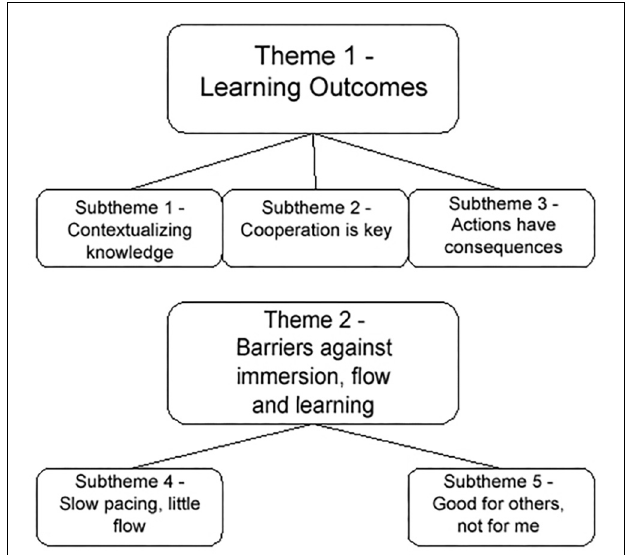
FIGURE 1 | Complete thematic